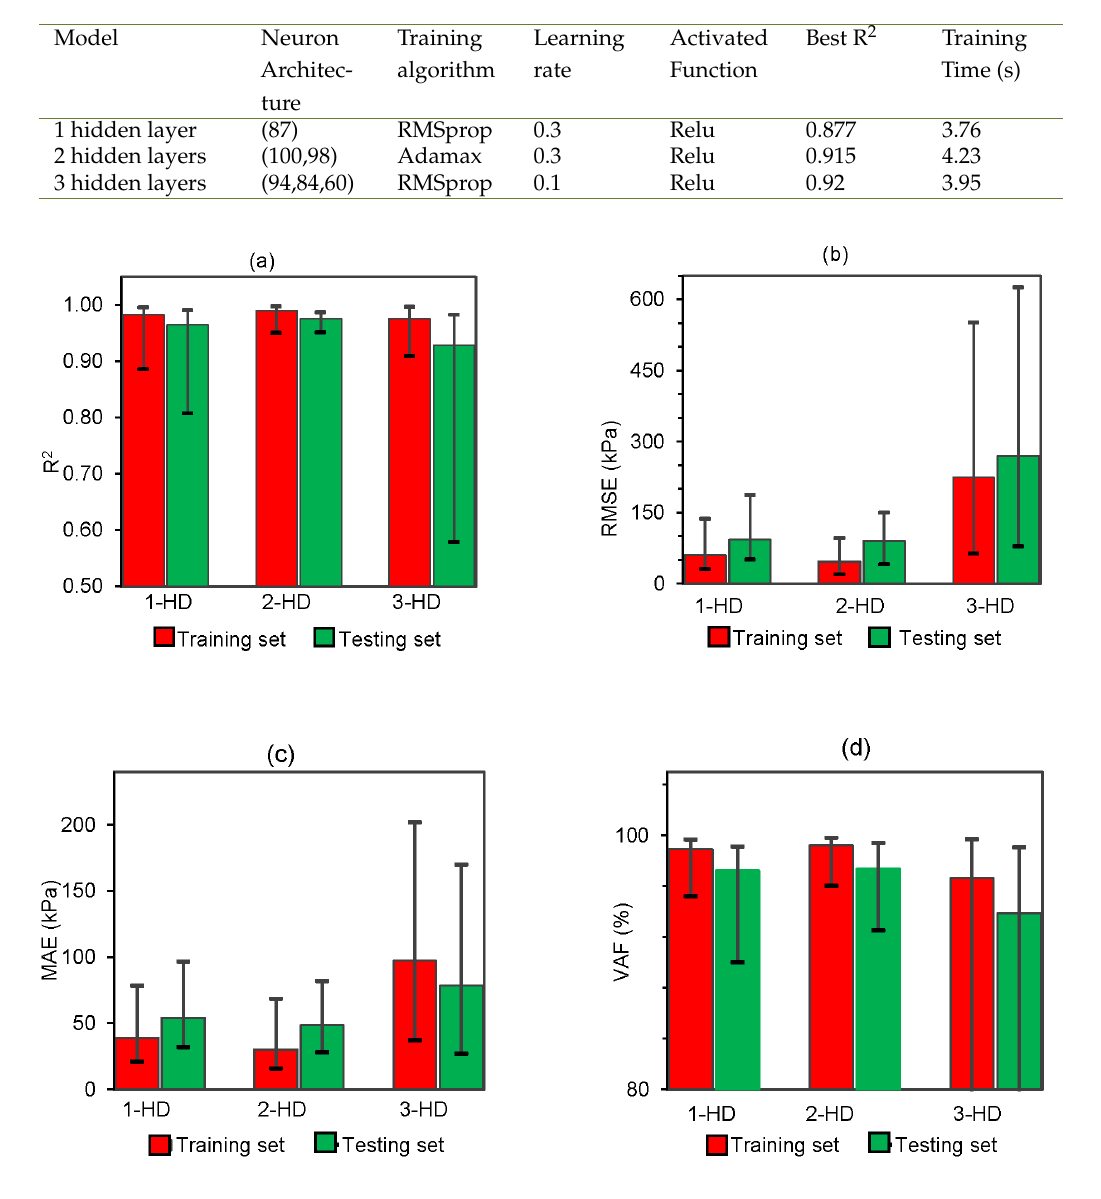
Table 4. Best DNN architectures